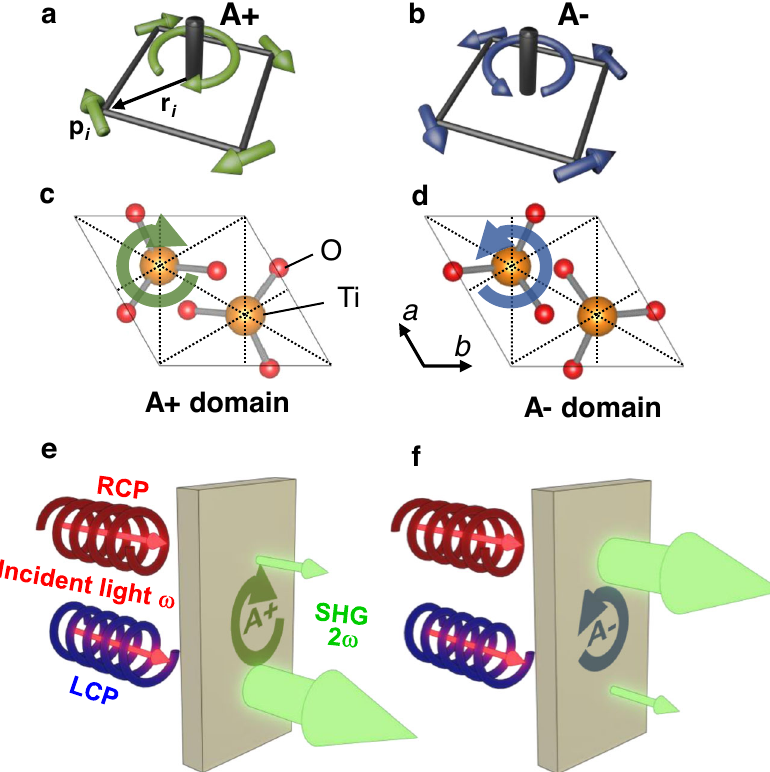
Fig. 1 Circular intensity difference (CID) in second harmonic generation (SHG) from ferroaxial materials. a , b Schematic illustrations of a pair of ferroaxial domain states with the opposite sign of ferroaxial moment A de fi ned as A / electric dipole p i from the symmetrical center of a structural unit. c , d Simpli fi ed c -axis views of a pair of ferroaxial domain states (A + and A − domains) in NiTiO 3 . e , f Conceptual diagram of CID-SHG from A + and A − domain states. The red and light green arrows denote fundamental circularly polarized light and SHG, respectively. The size of the light green arrows represents the intensity of SHG. Thus, the intensity of SHG from a ferroaxial material depends on both the circular polarization of fundamental light and the sign of A